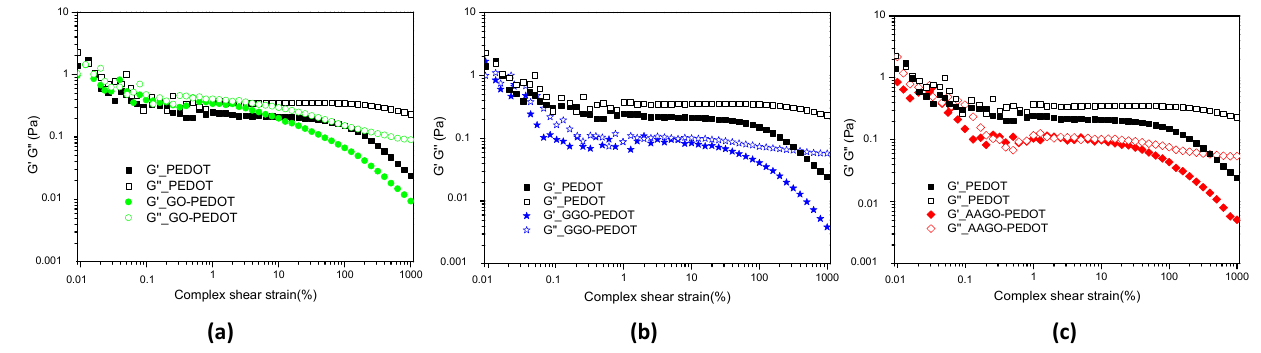
Figure 4. Dynamic Strain amplitude sweep tests on PEDOT compared with ( a ) GO-PEDOT, ( b ) GGO-PEDOT and ( c ) AAGO-PEDOT. Dependence of G′ (full) and G″ (empty) with the applied complex shear strain.